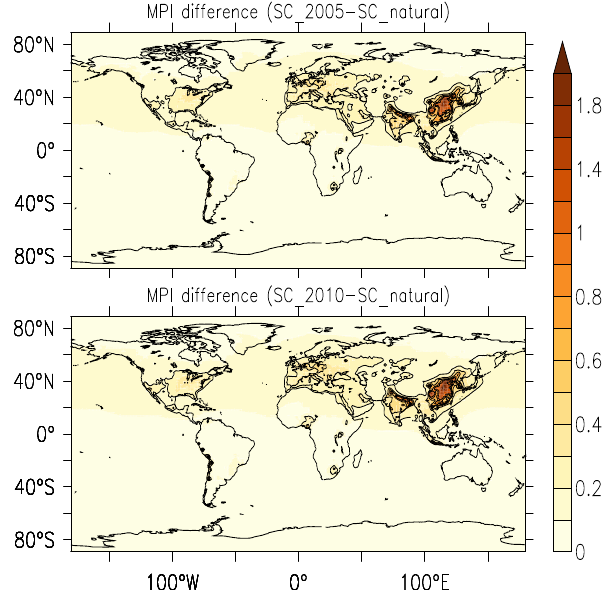
Fig. 10. Difference between the MPI estimated from simulations SC 2005 and SC 2010 and the MPI calculated from simulation SC natural . The contours are shown at multiples of 0.2 up to the level of 1.